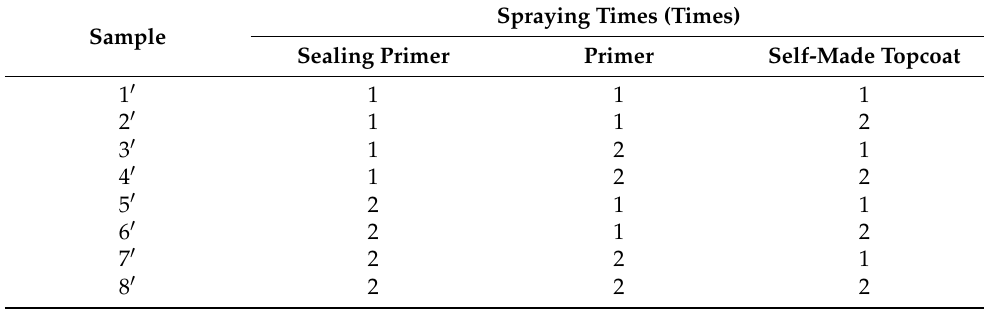
Table 3. Topcoat, primer, and sealing primer’s supporting scheme